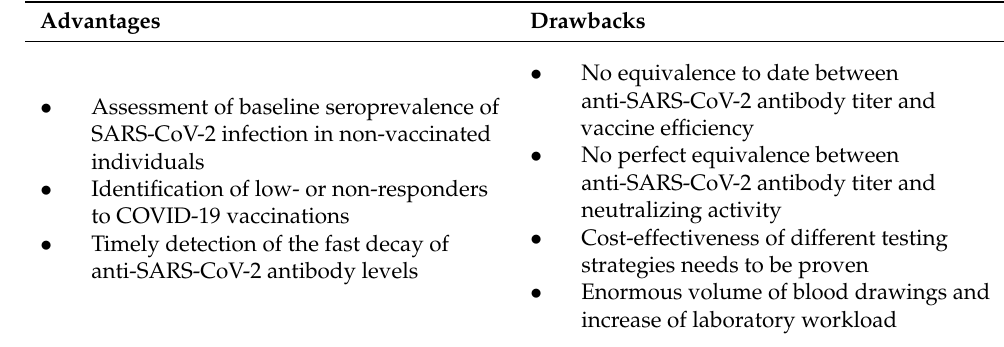
Table 4. Potential advantages and drawbacks of serological testing in recipients of COVID-19